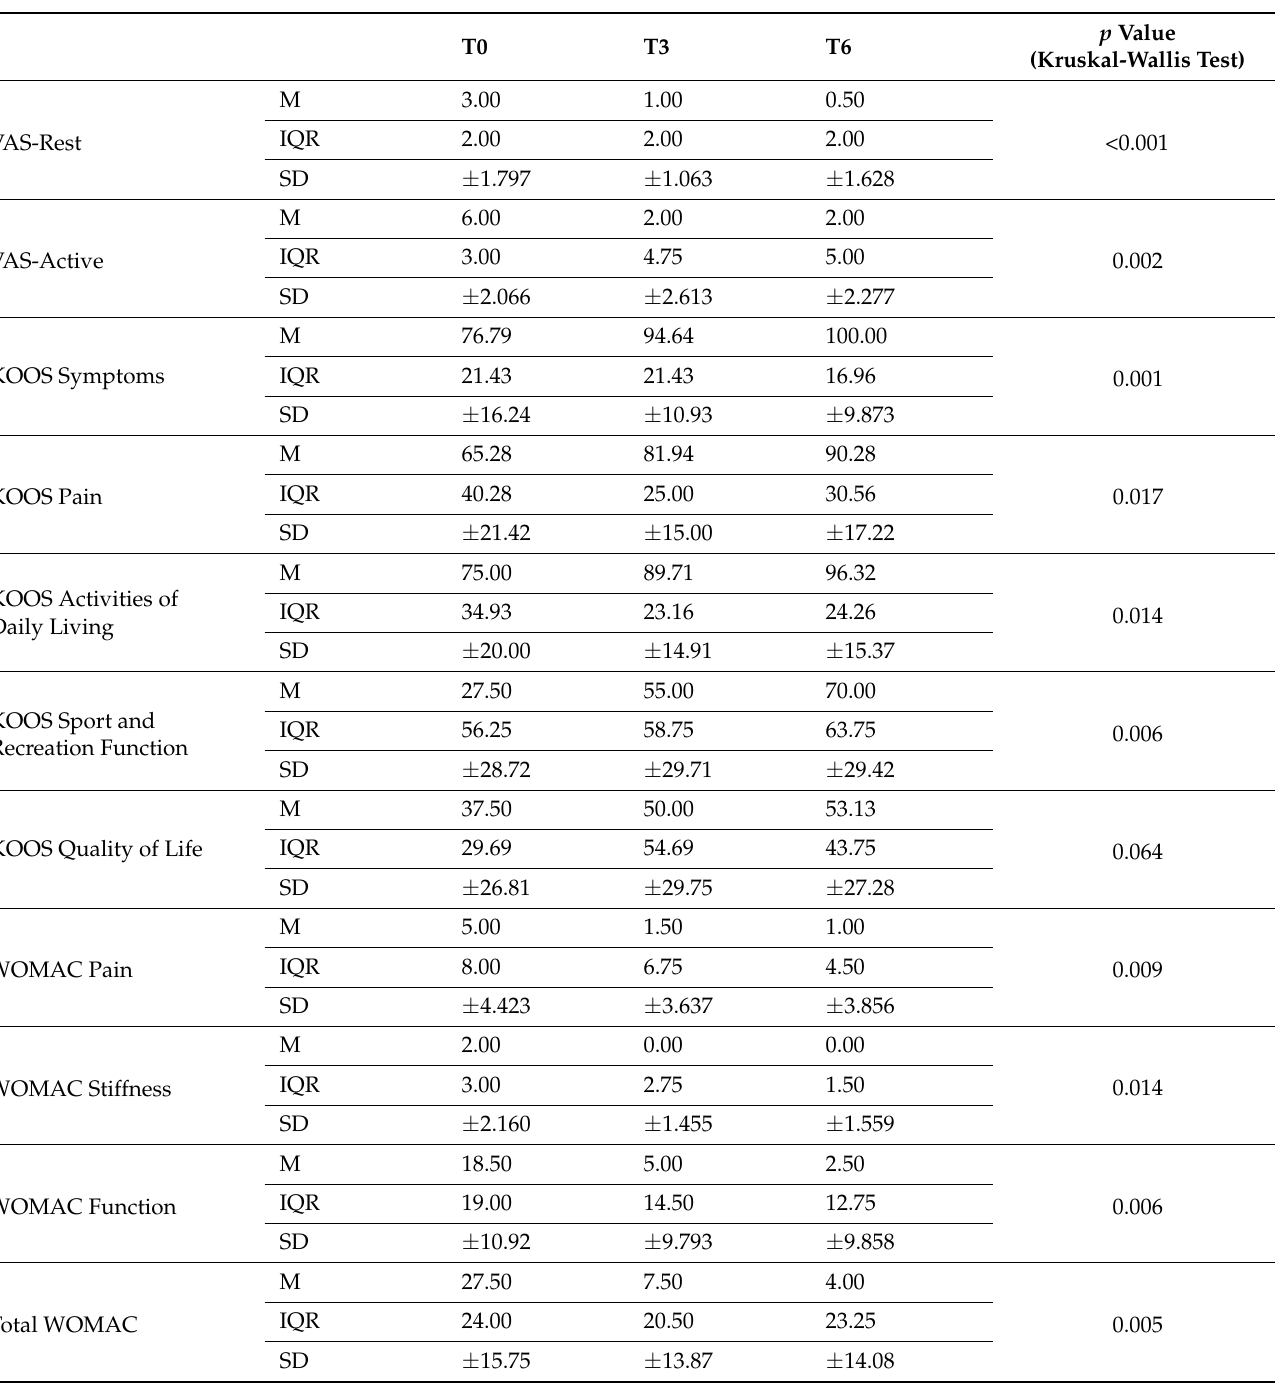
Table 2. Median values of VAS, KOOS, and WOMAC scores. M—median; IQR—interquartile range; SD—standard deviation; T0—baseline score; T3—score after 3 months; T6—score